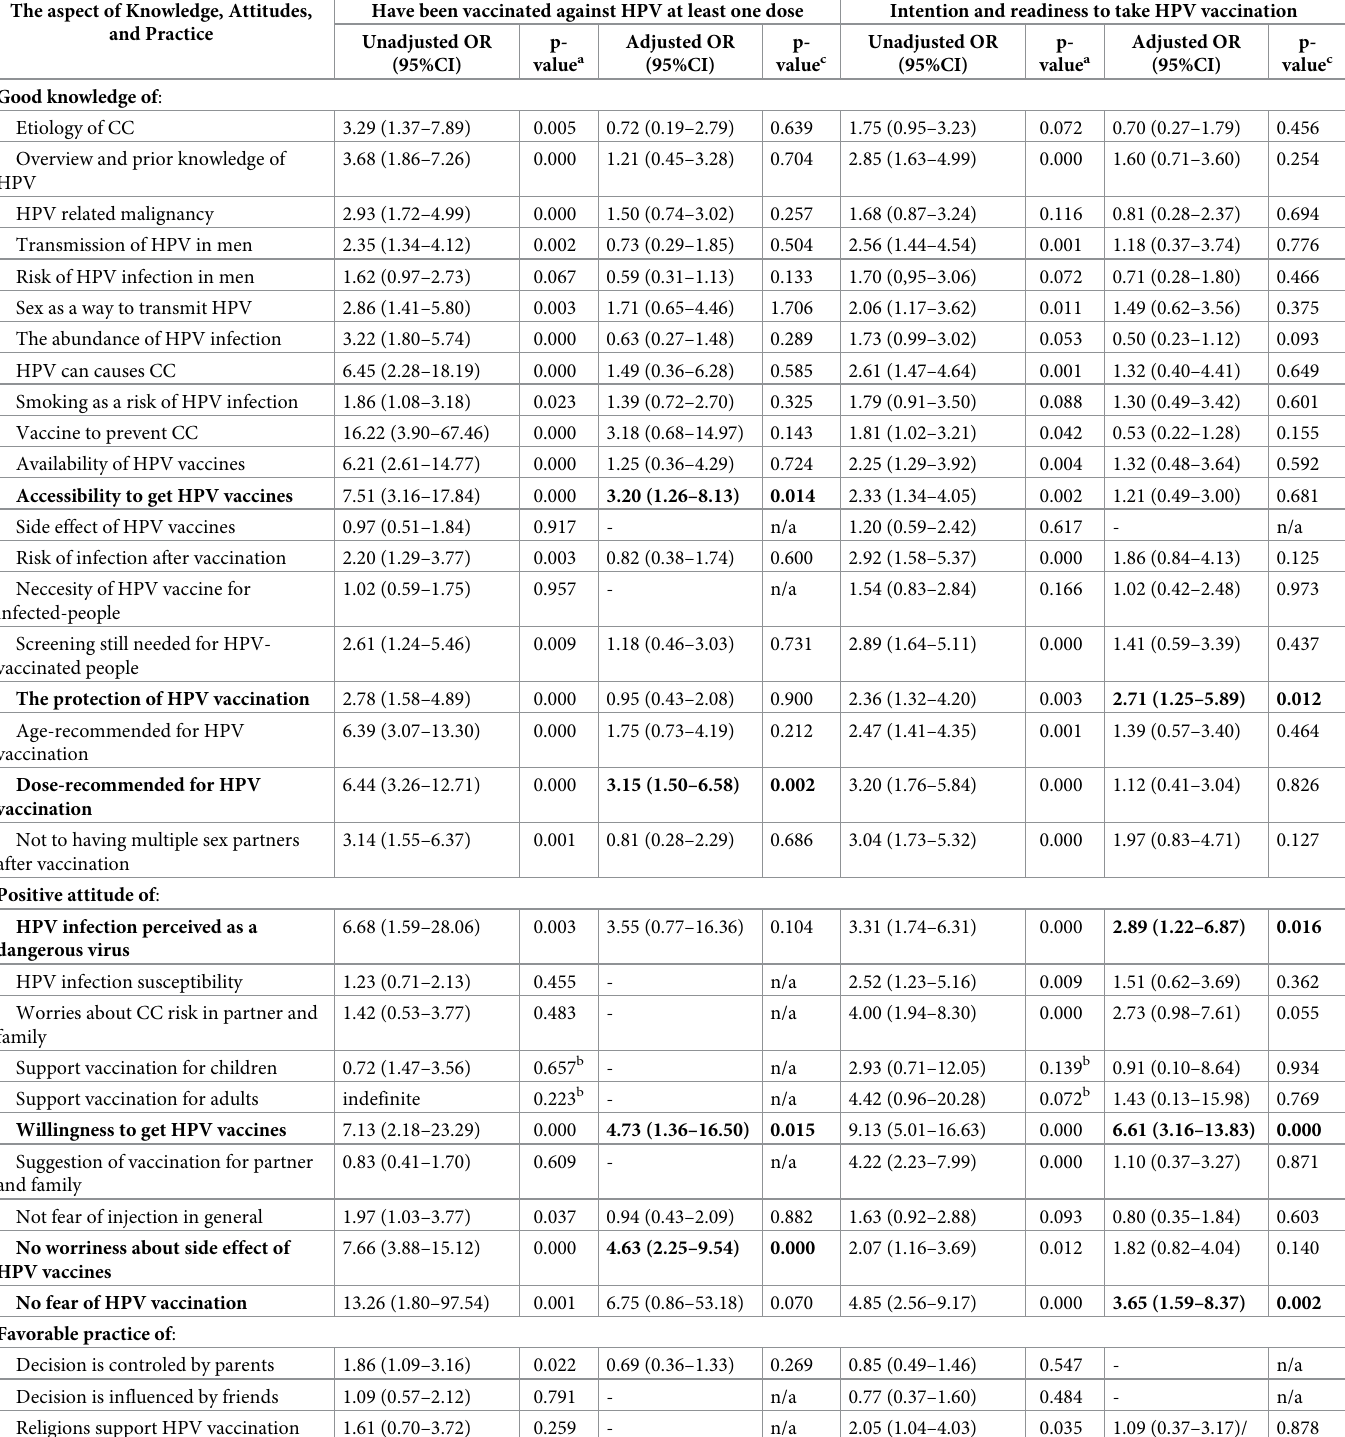
Table 6. Multivariate logistic regression model for the related aspect of KAP for getting vaccinated minimal one dose and willingness to get vaccinated among respondents (N =